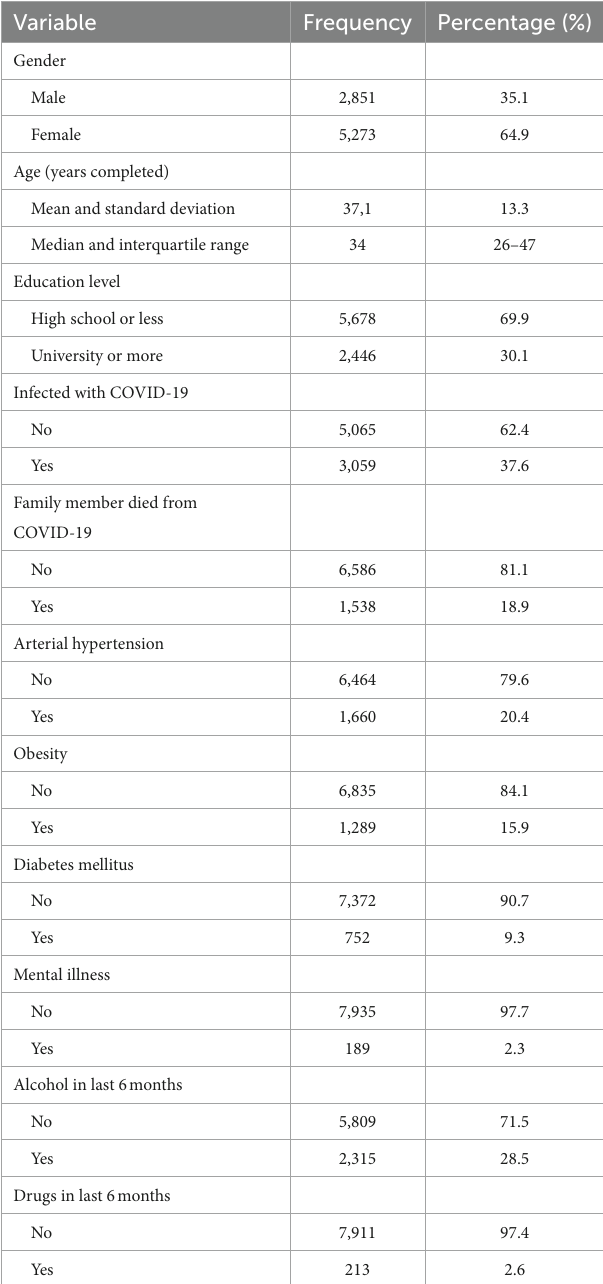
TABLE 1 General characteristics of the surveyed population of Honduras in the COVID-19 pandemic, period 2021–2022, ( n = 8,125).